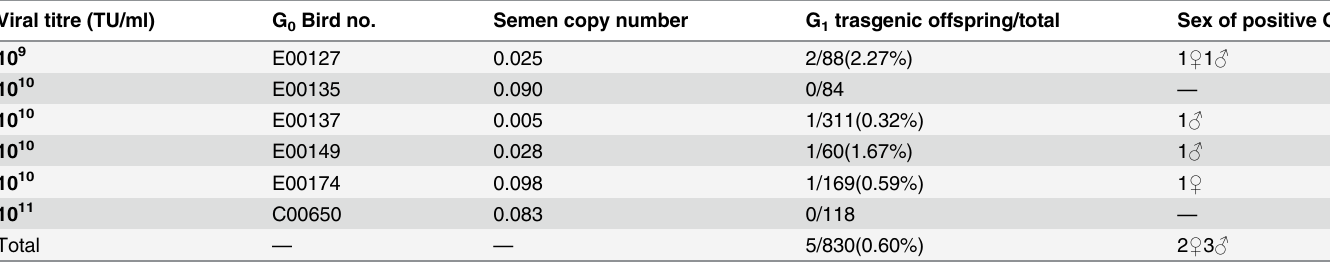
was 48.6%. Table 1. Q-PCR analysis of semen DNA from hatched male chickens and the ef fi ciency of germline transmission. Viral titre (TU/ml) G 0 Bird